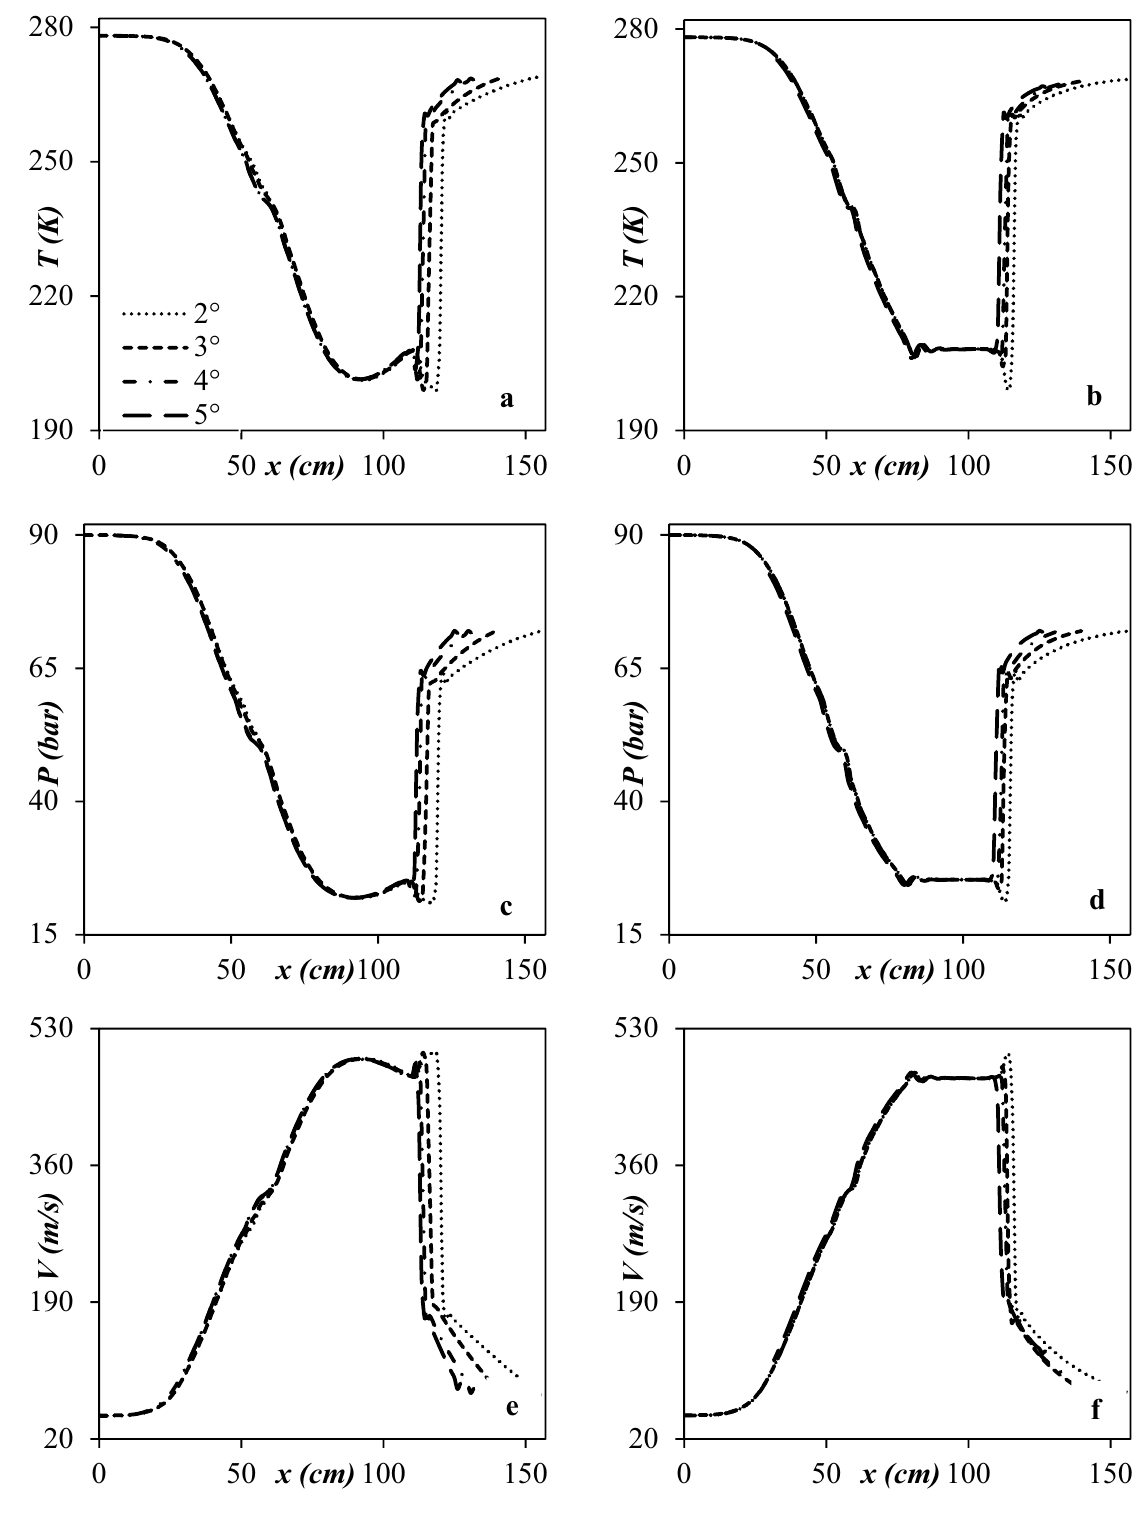
Figure 6. Temperature ( a , b ), pressure ( c , d ) and velocity ( e , f ) profile for two different line types ( a , c , e ) Curved wall diffuser ( b , d , f ) Linear wall